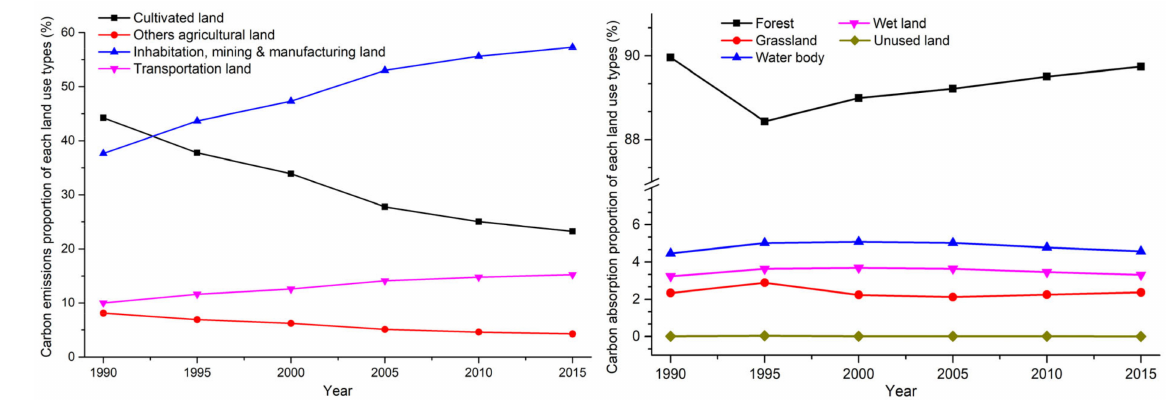
Figure 3. The carbon emissions/absorption of different land-use types in the